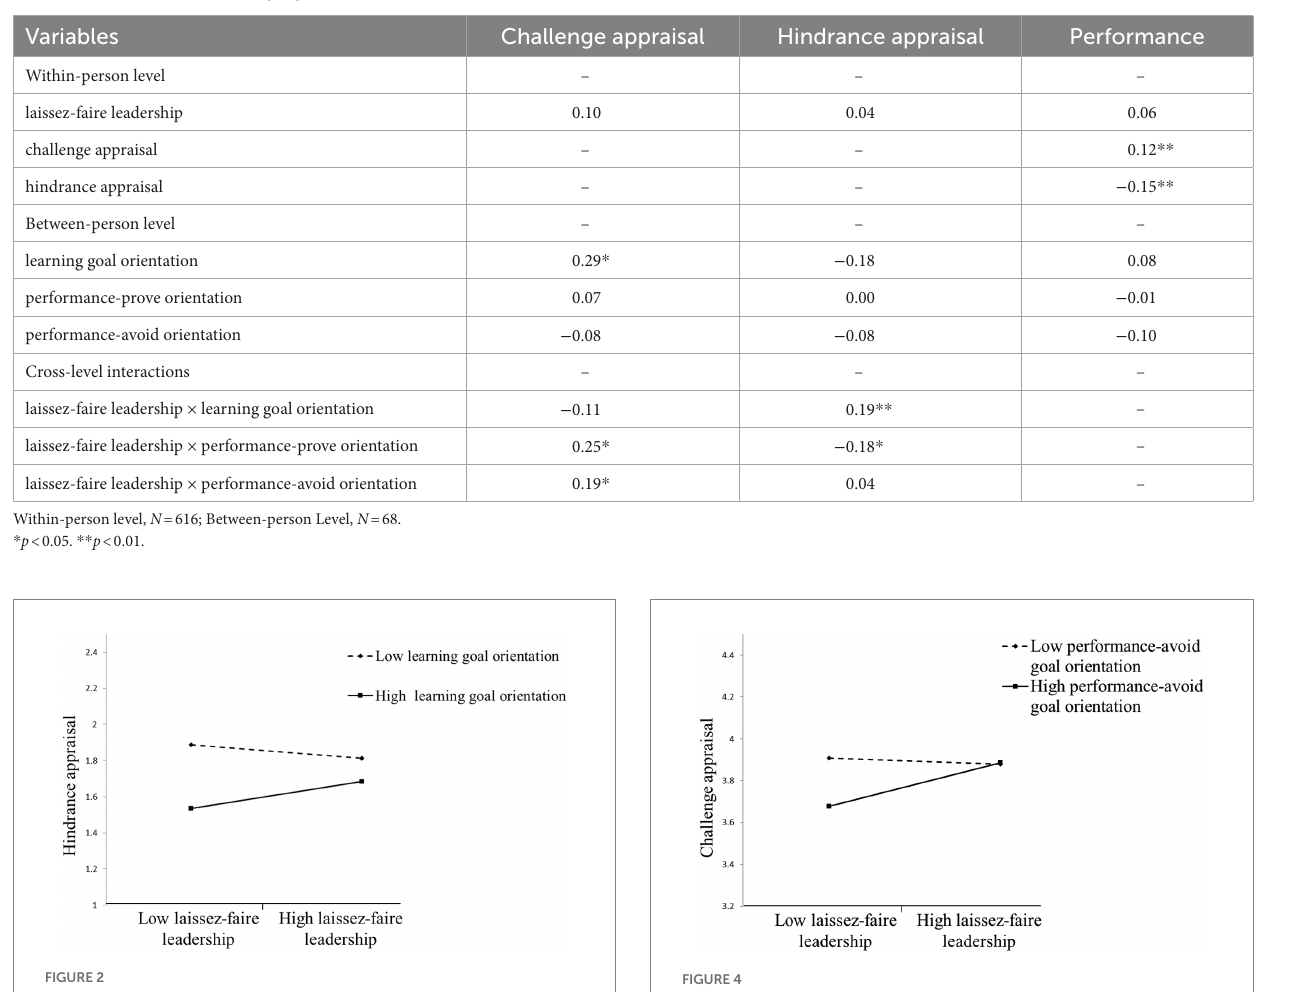
TABLE 2 Results for the test of proposed model.